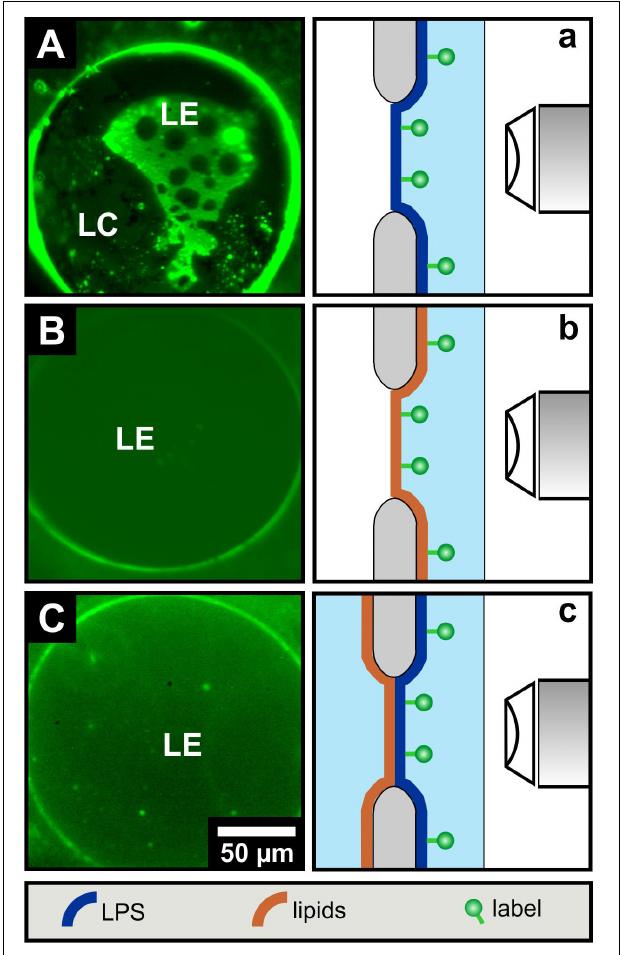
FIGURE 3 | LPS R45 free-standing planar monolayers lose their phase separation upon combination to an LPS R45/PL free-standing bilayer. Fluorescence microscopic images of (A) a LPS R45 monolayer, (B) a PL (PE:PG:CL; 81:17:2; w/w/w) monolayer, and (C) a LPS R45/PL planar bilayer reconstituted over an aperture. For fluorescence labeling of an individual membrane leaflet, the lipid monolayer was supplement with 1% NBD-PE which partitions into the liquid expanded (LE) domains. As with the solid-supported membranes, phase separation in free-standing lipid systems occurred only for the LPS R45 monolayer. Experiments were conducted in 100 mM KCl, 5 mM MgCl 2 , 5 mM HEPES at pH 7.0 and T = 37 ◦